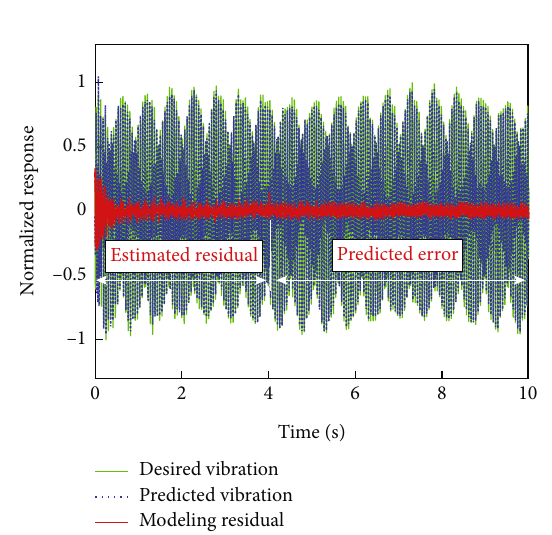
Figure 5: Estimated residual and predicted error in system identi fi cation.